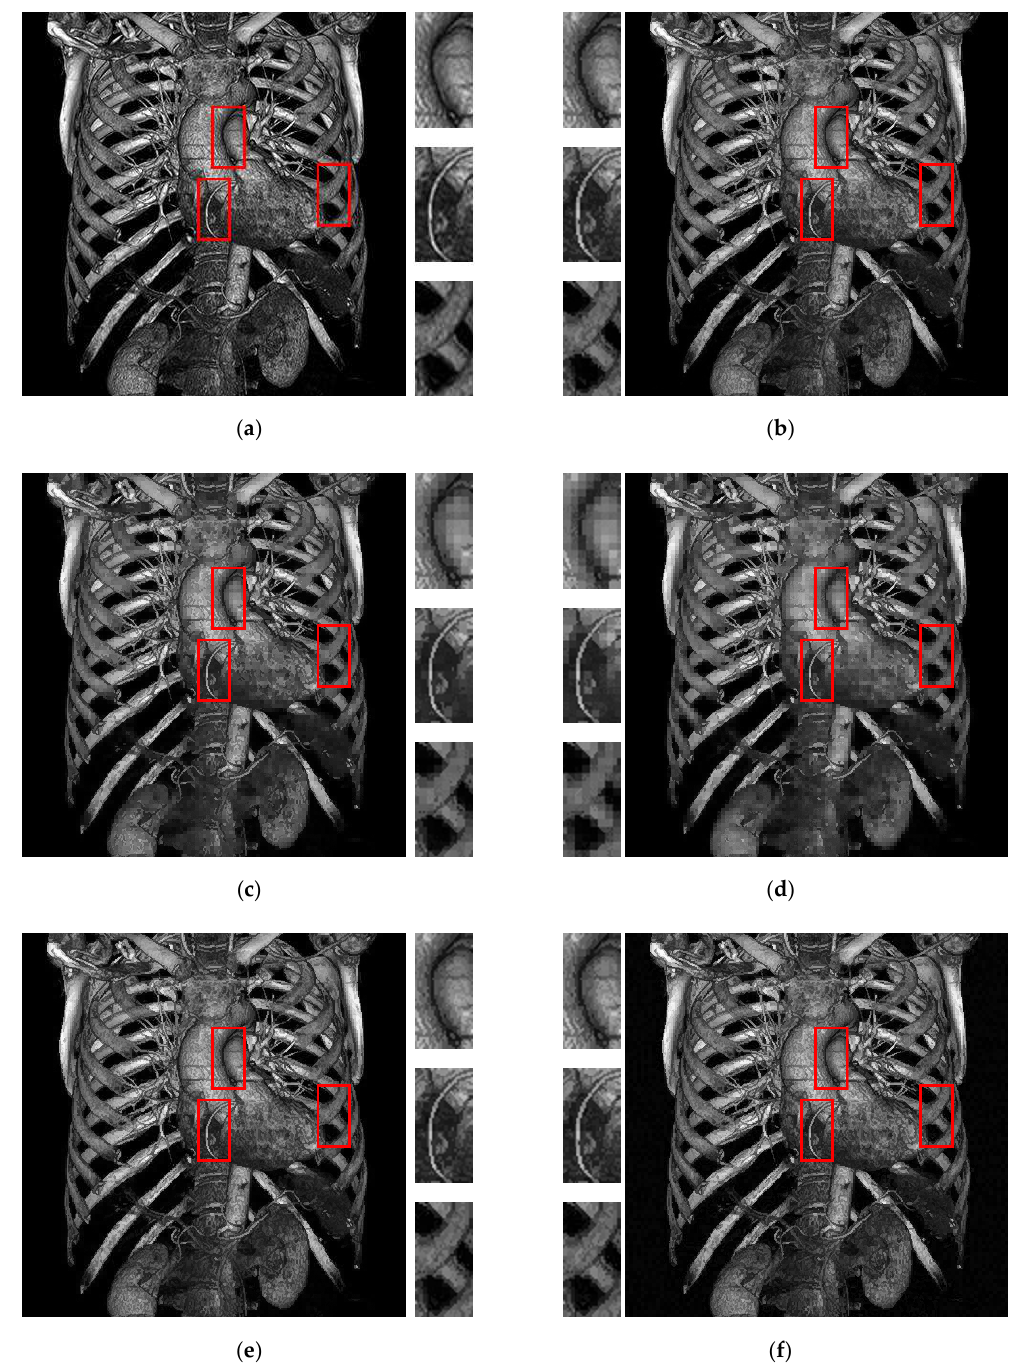
Figure 8. Results of visual comparison using the test image Artifix. ( a ) Original grayscale. ( b ) Pure AMBTC without data embedding. ( c ) Result of [17]. ( d ) Result of [20]. ( e ) Result of [22]. ( f ) Result of the proposed method. From ( c ) to ( f ), the threshold value is set as 8.